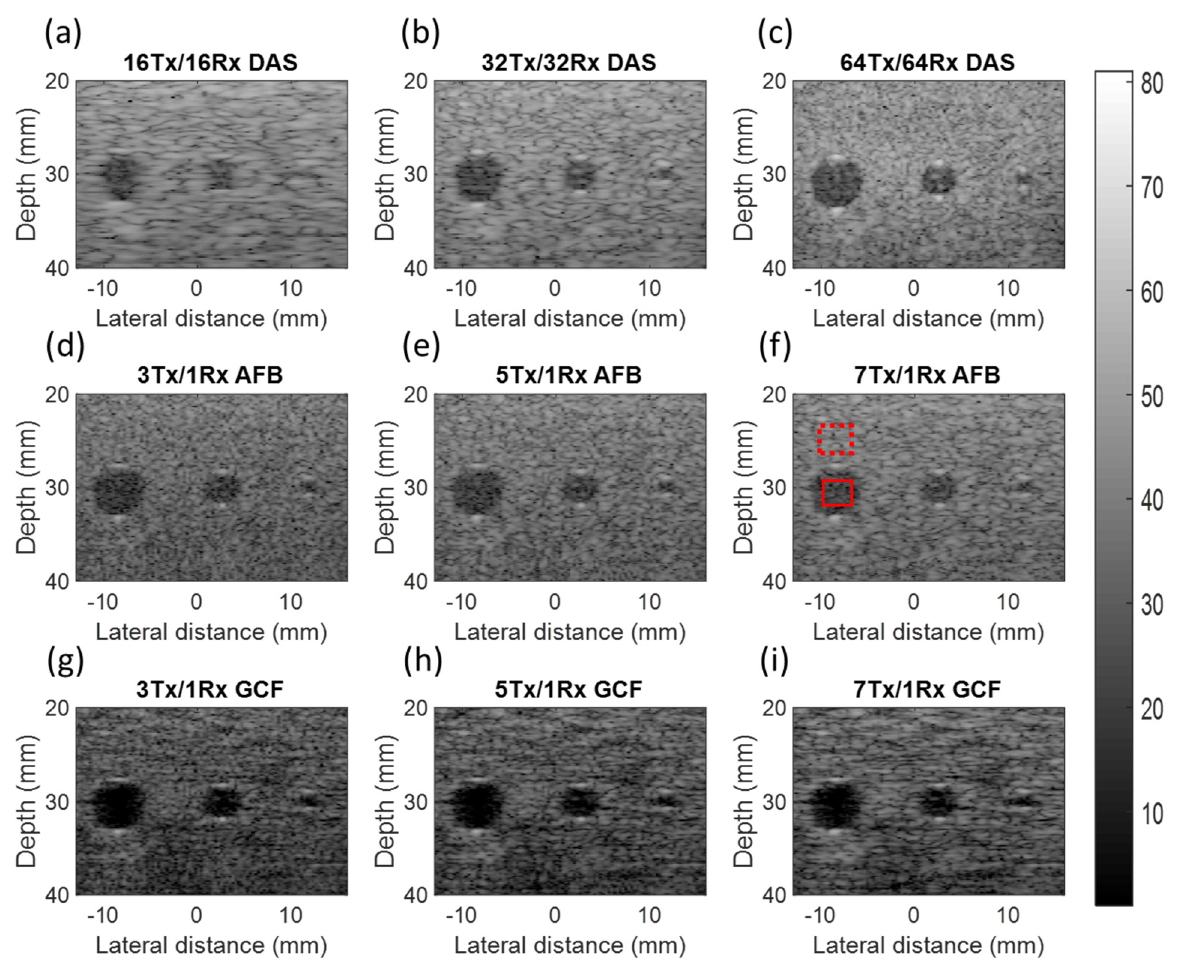
Figure 7. Anechoic cysts experimental results of nine methods. ( a ) 16 Tx/16 Rx DAS. ( b ) 32 Tx/32 Rx DAS. ( c ) 64 Tx/64 Rx DAS. ( d ) 3 Tx/1 Rx AFB. ( e ) 5 Tx/1 Rx AFB. ( f ) 7 Tx/1 Rx AFB. ( g ) 3 Tx/1 Rx GCF. ( h ) 5 Tx/1 Rx GCF. ( i ) 7 Tx/1 Rx GCF. Table 3. Contrast (CR), standard deviation (STD), and contrast-to-noise ratio (CNR) of the images acquired using nine methods, as shown in Figure 7.